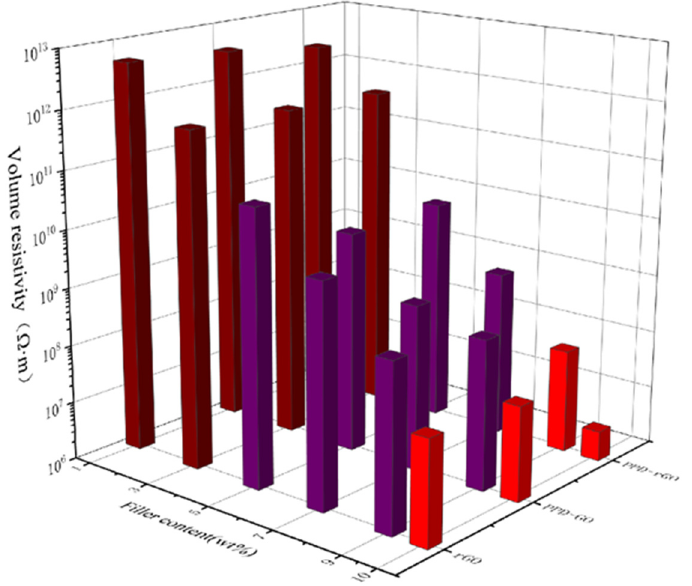
Figure 8. Volume resistivity diagram of composite material.